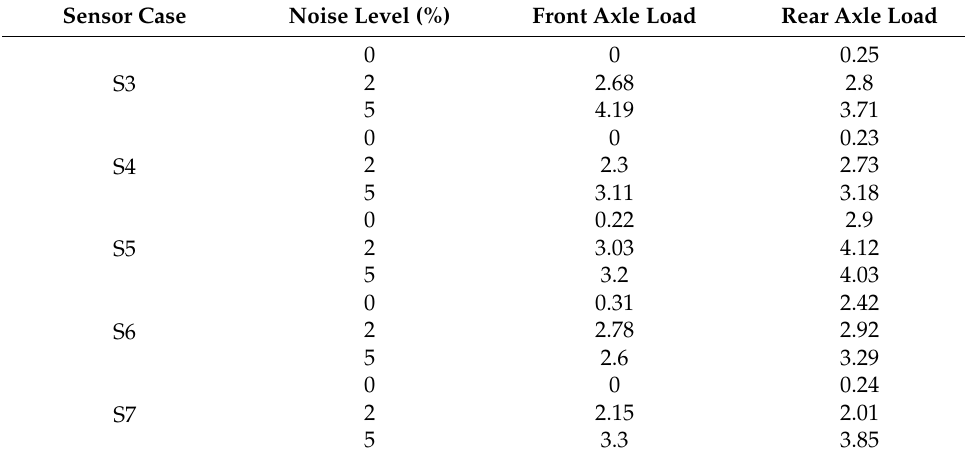
Table 4. The relative error (%) of the identified forces for different sensor